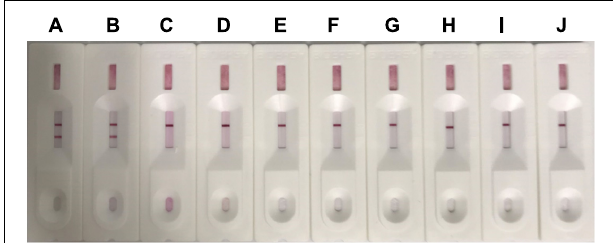
FIGURE 4 | Specificity testing of the ICS. The following viruses were tested using the ICS assay developed in this study: canine adenovirus 1 (CAdV-1; strip A ), CAdV-2 (strip B ), canine rabies virus (CRV; strip C ), canine distemper virus (CDV; strip D ), canine coronavirus (CCV; strip E ), canine parainfluenza virus (CPIV; strip F ), canine leptospira virus (CLV; strip G ), canine parvovirus (CPV; strip H ), Dulbecco’s modified Eagle’s medium (control; strip I ), and MDCK cells (control; strip J ).